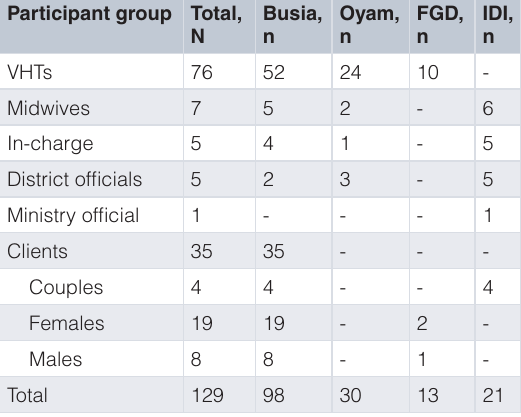
Table 1. Sample of focus group discussion (FGD) and interview participants. Participant group Total,